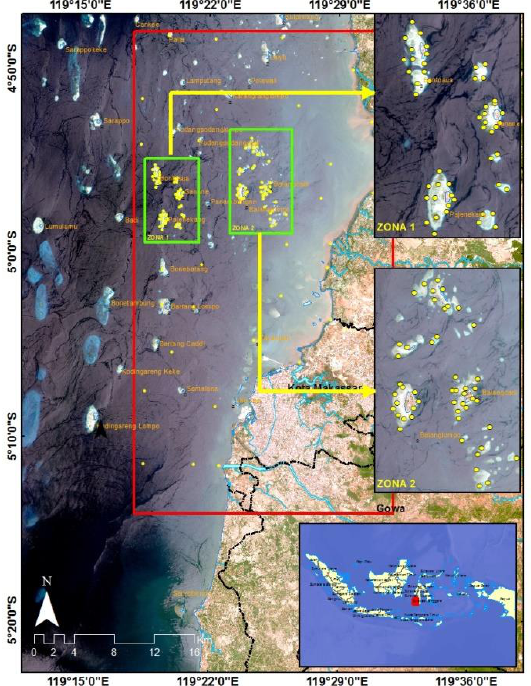
Figure 1. Spermonde water as a field location. Red line is border of Total Solid Suspended study area and yellow point is sampling